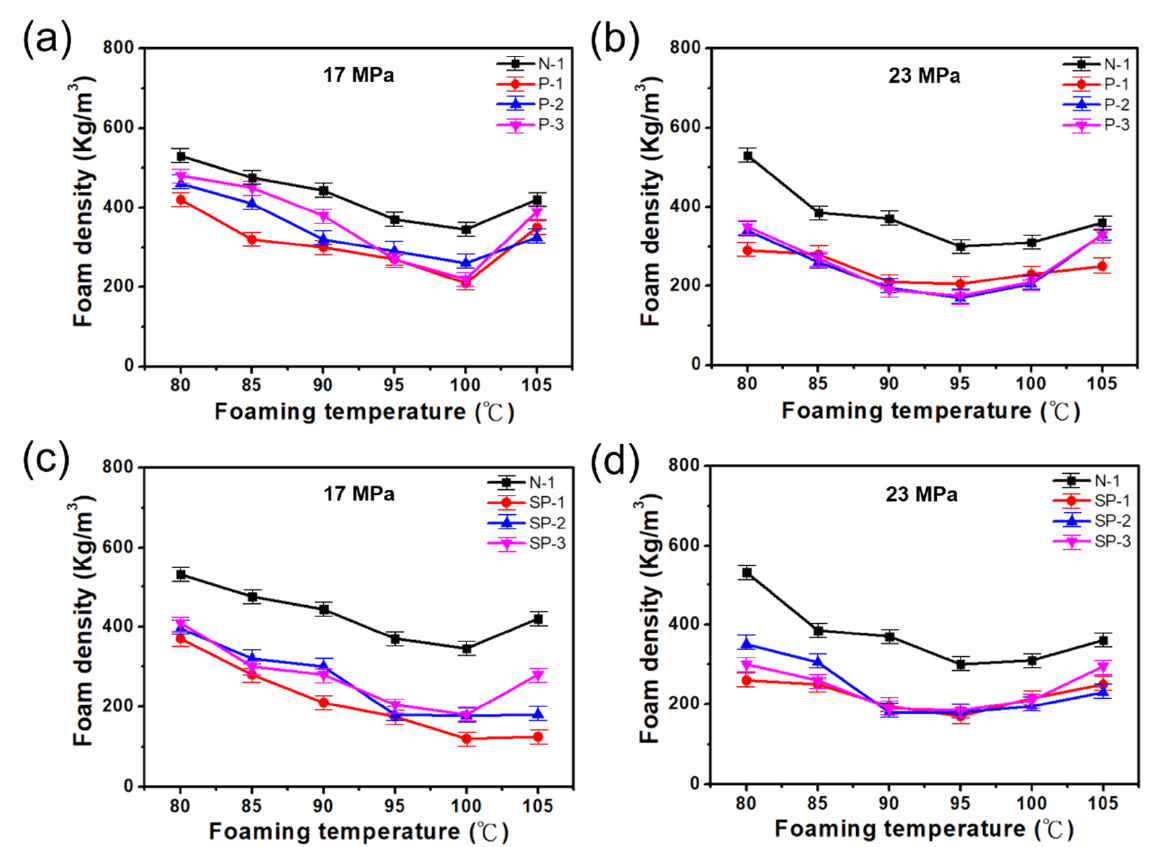
Figure 2. Dependence of (PEG-TPS)/PBAT and (PEG-TPS with SA)/PBAT composite foam density under six foaming temperatures and different foaming pressures. ( a , c ) Variation in composite foam density at 17 MPa. ( b , d ) Variation in composite foam density at 23 MPa.